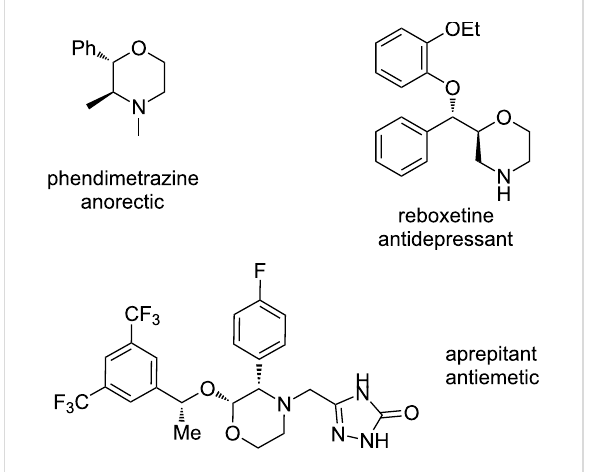
Figure 1: Pharmaceutically active 2- and 2,3-disubstituted morpho- lines.